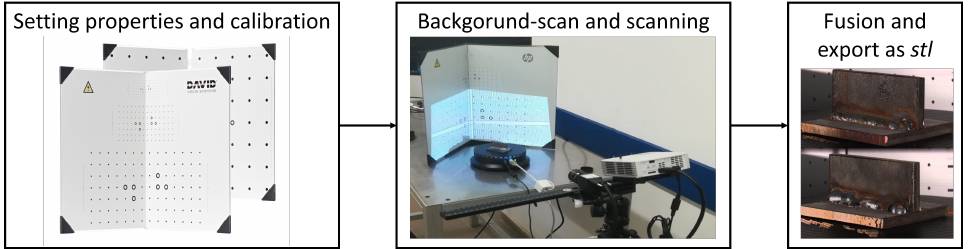
Figure 2. The 3D scanning process: (1) calibration of the tray with recommended